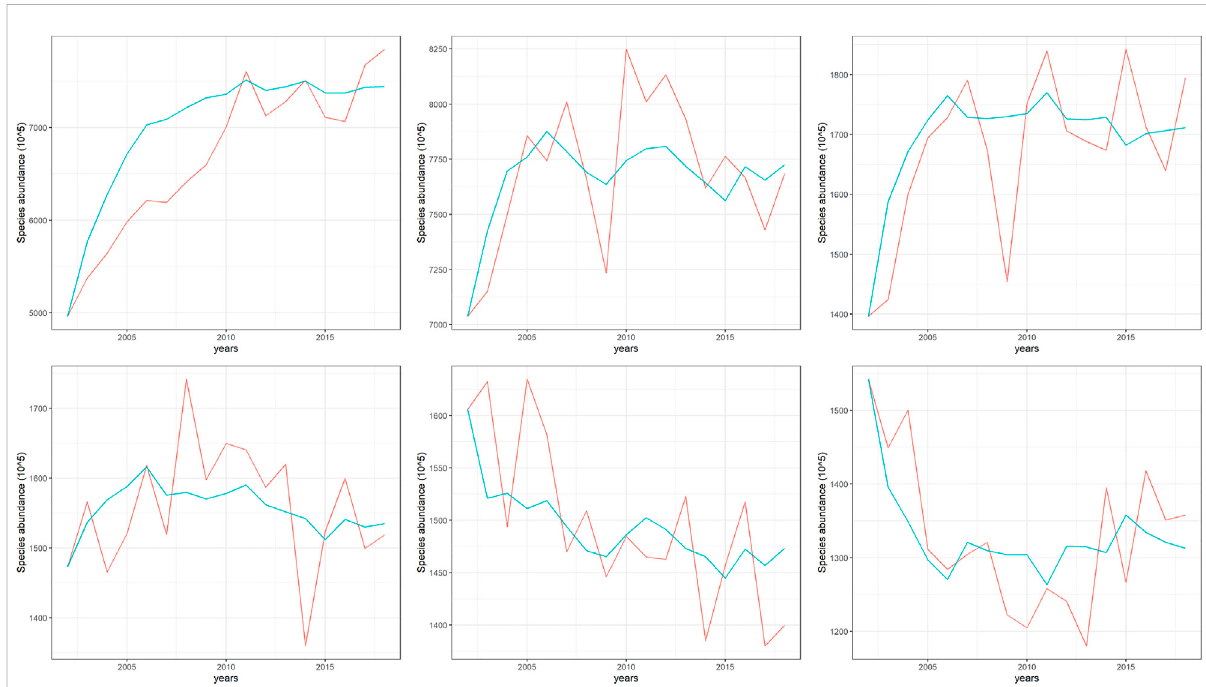
FIGURE 2 Descriptive performance of the predictive ecological model: comparison of predicted bird abundances values (blue line) with historical abundances (red line) for a sample of species. First row: Wood Pigeon Columba palumbus , Chaf fi nch Fringilla coloebs , Great spotted